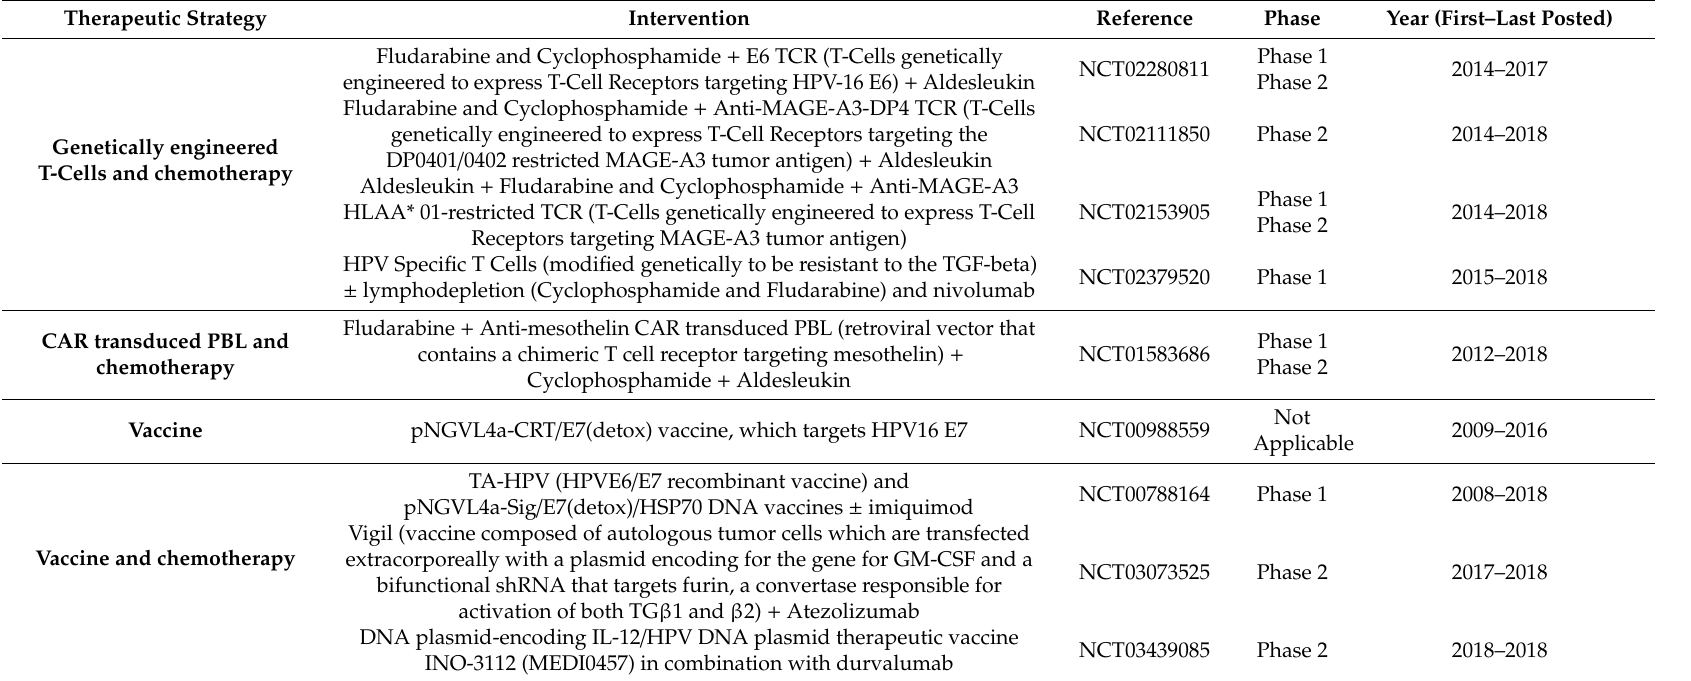
Table 2. Current immunogene therapy clinical trials available in clinicaltrials.gov